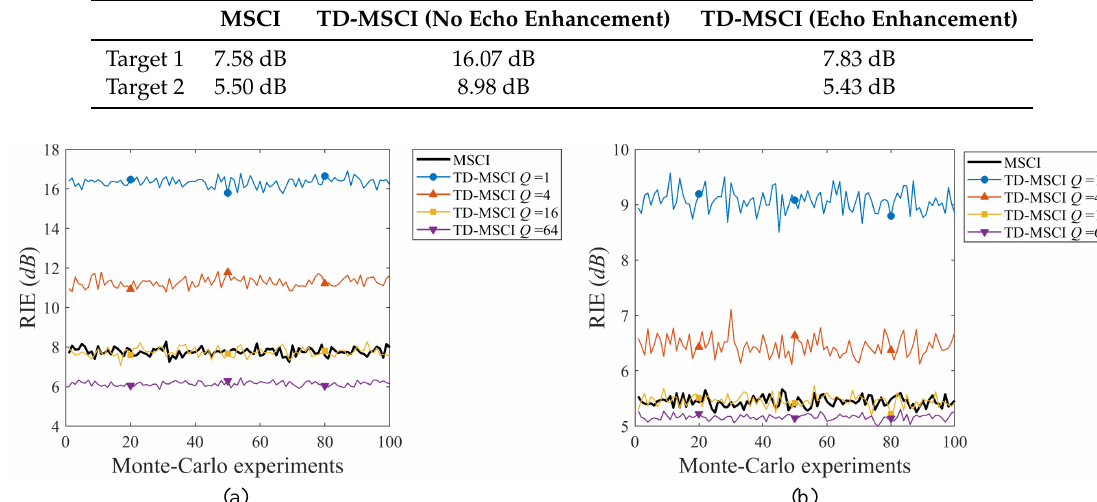
Table 2. Relative imaging error (RIE) of reconstruction results.